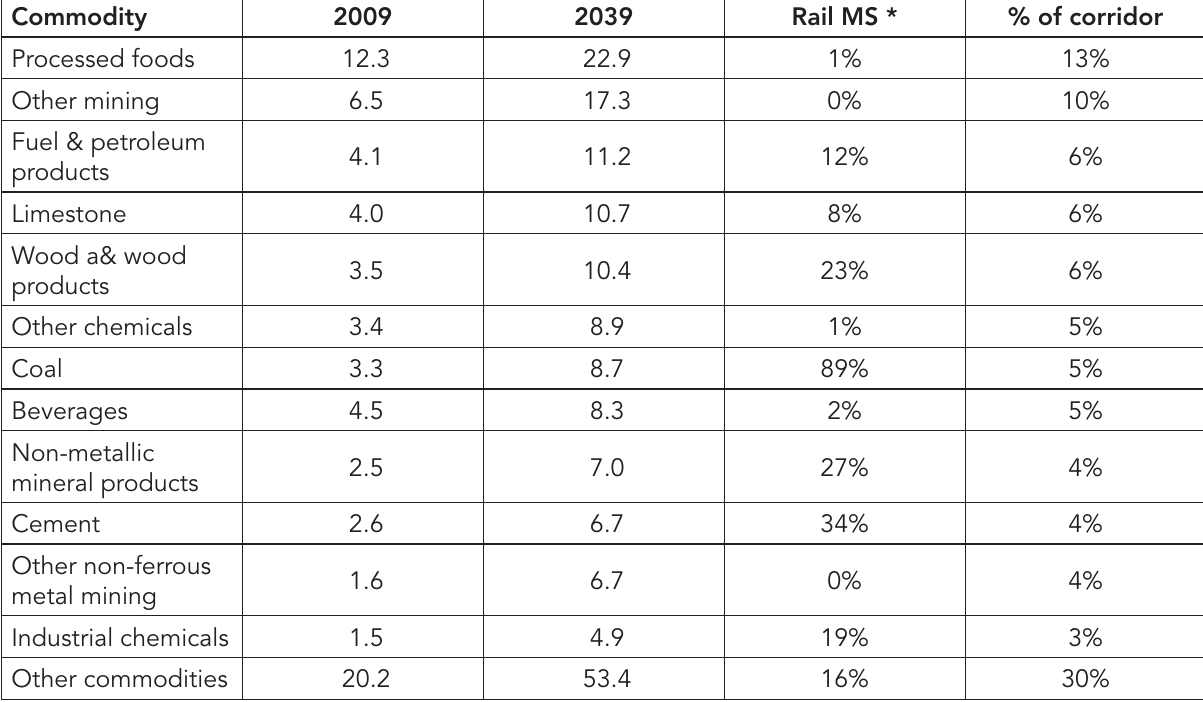
Table III: Pareto analysis (based on 2039 ton-km) of commodities for